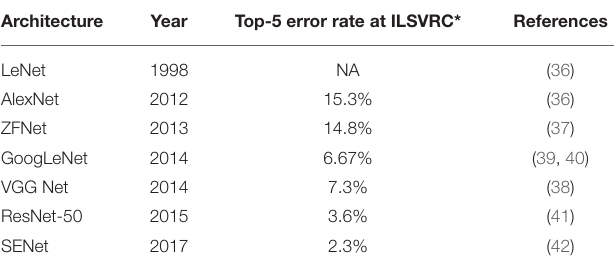
TABLE 1 | List of CNN